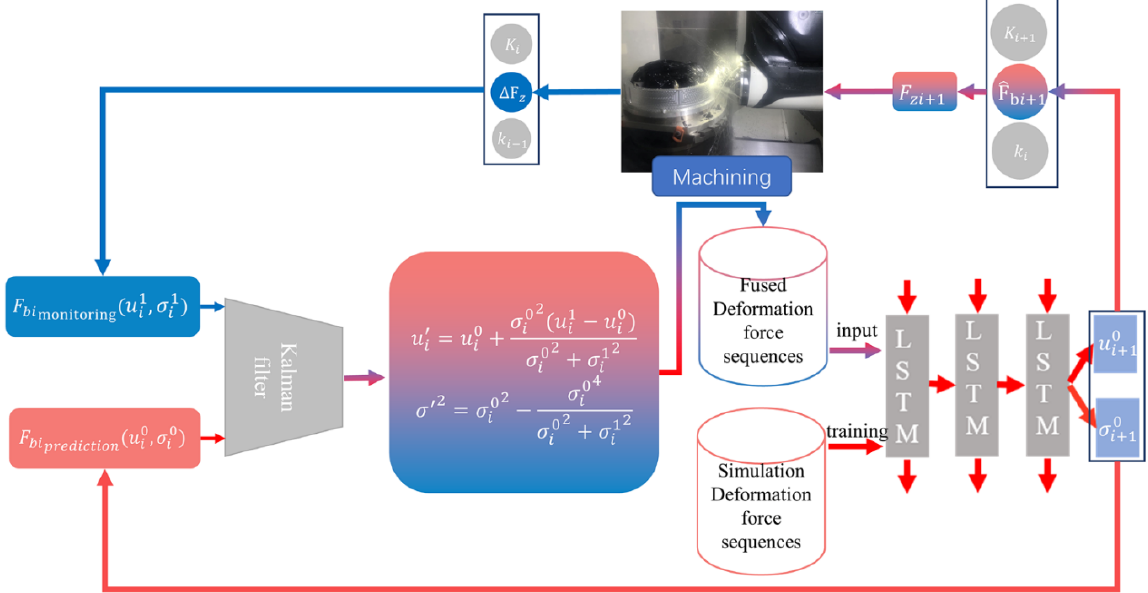
Figure 3. The structure of deformation force prediction model based on deep autoregressive neural network and Kalman filter.